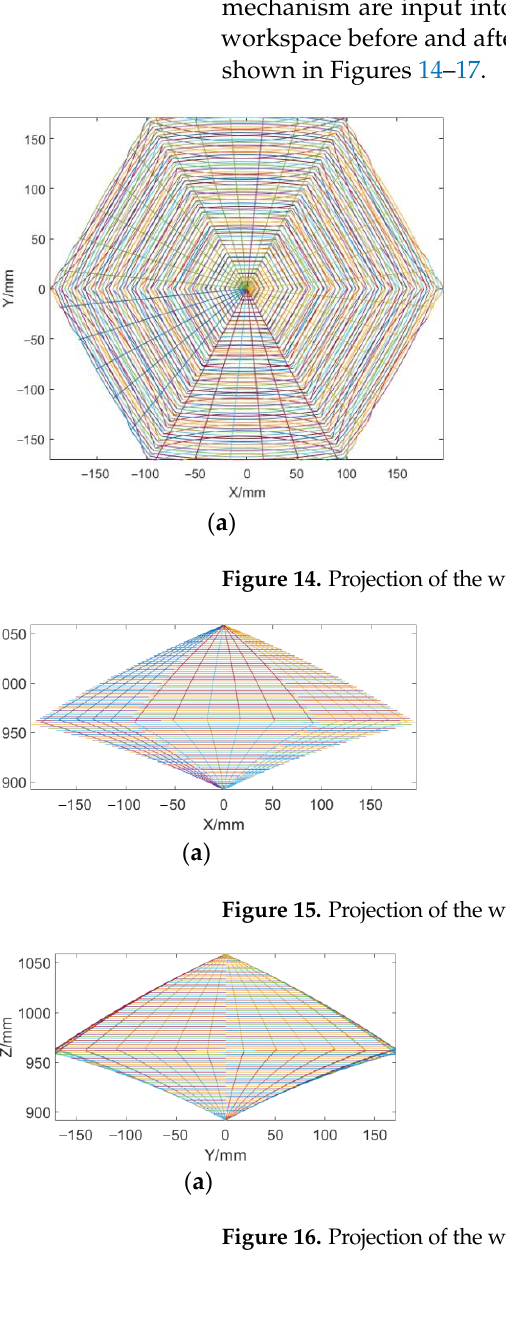
( b ) Figure 17. Three-dimensional distribution of the workspace: ( a ) Before optimization; ( b ) After op- timization. It can be seen from Figures 14 – 17 that the motion range of the optimized 6-UPS parallel mechanism extends to different degrees in the X , Y , and Z axes, and the motion range in the X axis is changed from [ − 196.89, 196.89] to [ − 242.20, 242.20]; the motion range in the Y axis is changed from [ − 171.03, 171.03] to [ − 212.18, 212.18]; the motion range in the Z axis is changed from [896.91, 1058.93] to [1021.70, 1185.63], and the motion range of the mechanism is significantly expanded. 7. Conclusions In this article, the multi-objective optimization design of the 6-UPS parallel mecha- nism is carried out based on the parametric modeling technology, the Taguchi method and EGRA method. The parametric model of the 6-UPS parallel mechanism is estab- lished by ADAMS software, and the validity and accuracy of the parametric model are verified by theoretical calculation. The relationship between the design variables and the objective function is investigated by establishing the design variables, objective function,